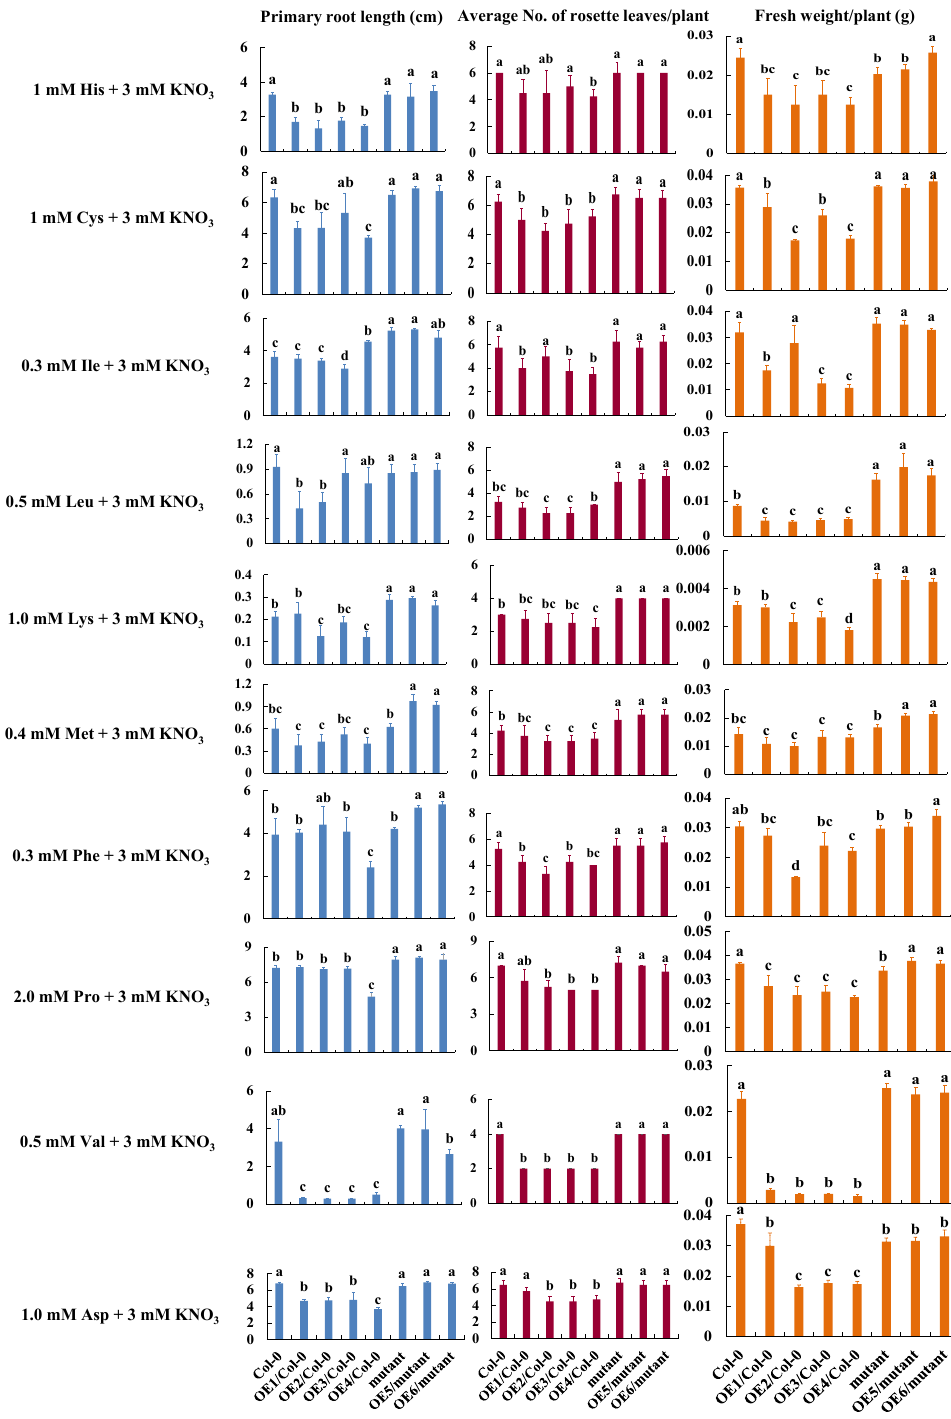
Figure 6. Growth performances of CsCAT9.1 -OE Arabidopsis seedlings grown in medium supplemented with individual amino acids. The NO 3 − treatment served as a control of N source (Figure S10). OE1, OE2, OE3, and OE4 represent independent overexpression lines with WT background, OE5 and OE6 represent independent complementary lines with cat9 mutant background. Error bars indicate SD. Statistically significant differences are indicated by letters a, b, c, and d ( p = 0.05).